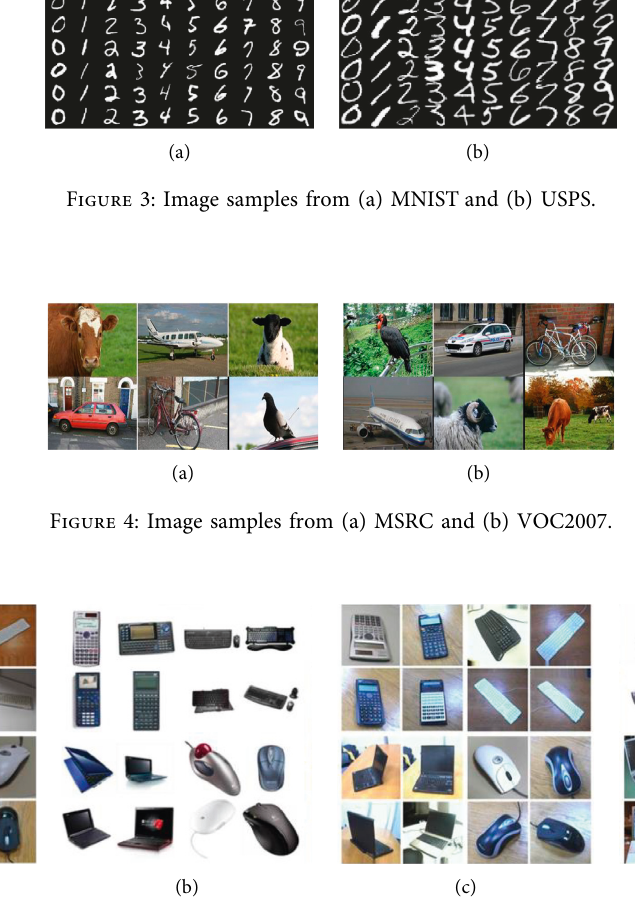
Figure 5: Image samples from Amazon, Caltech, DSLR, and Webcam. (a) DSLR. (b) Amazon. (c) Webcam. (d)